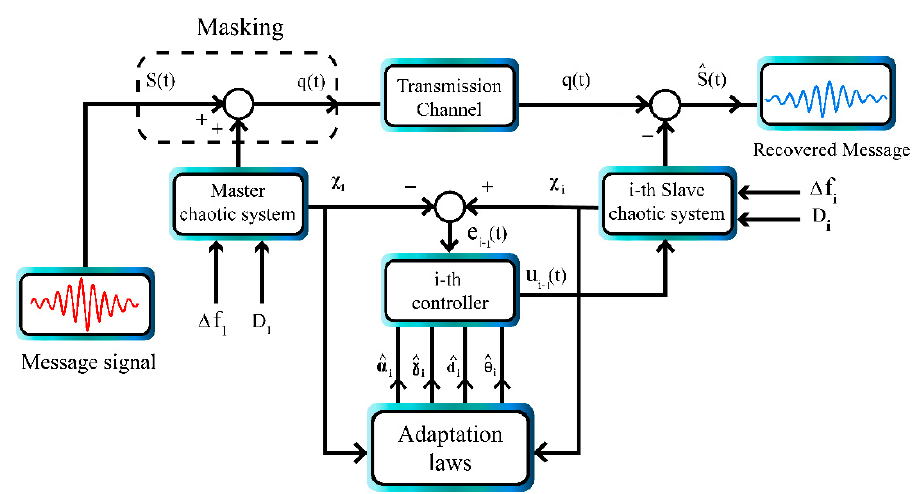
Figure 2. Block diagram of chaotic masking using multi-state